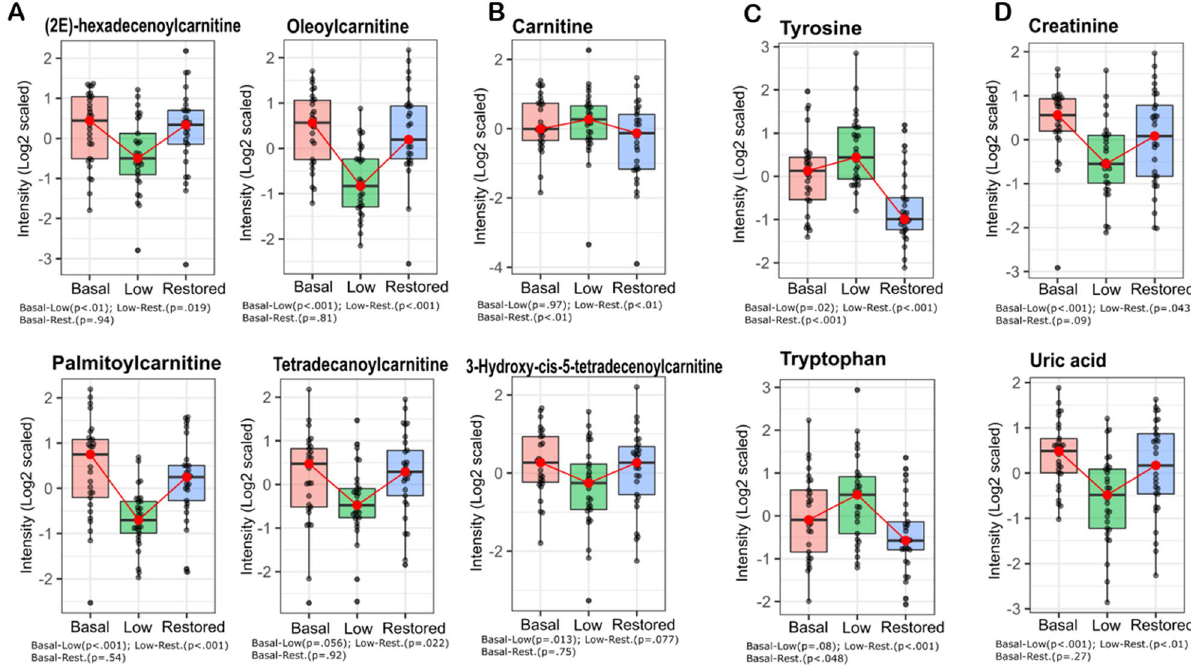
Figure 4. Markers of testosterone levels. Levels of some metabolites after TD and TS. ( A ) Some acylcarnitines: (2E)-hexadecenoylcarnitine *,# , Oleoylcarnitine *,# , Palmitoylcarnitine *,# , 3-Hydroxy-cis-5-tetradecenoylcarnitine * , and Tetradecanoylcarnitine *,# . ( B ) Carnitine #, ǂ . ( C ) Aromatic amino acids: Tyrosine *,#, ǂ , and Tryptophan #, ǂ . ( D ) Biomarkers of kidney function: Creatinine *,# , and Uric acid *,# . Boxplot colors: Pink, Basal testosterone group; Green, Low testosterone group; Blue, Restored testosterone group. * p value ≤ 0.05, Basal versus Low, # p value ≤ 0.05, Low versus Restored, ǂ p value ≤ 0.05, Basal vs .